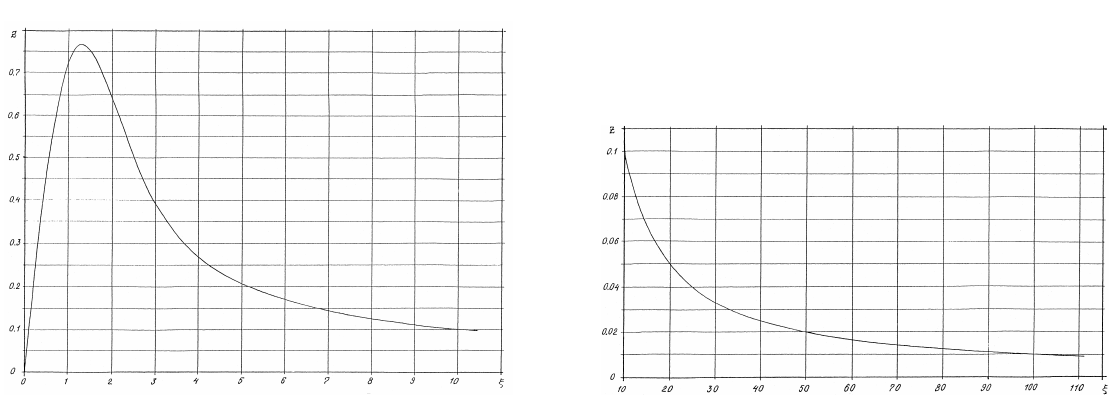
Figure 6. Plot of the function Z ( ξ ) defined in Equation